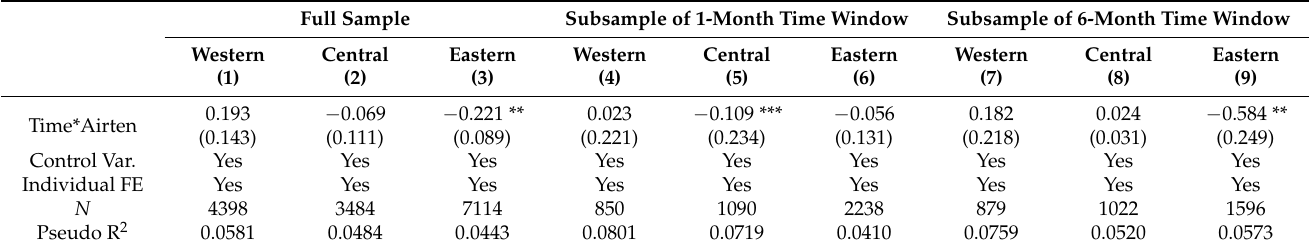
Table 5. Ordinal logistic results of heterogeneity analysis in different regions of